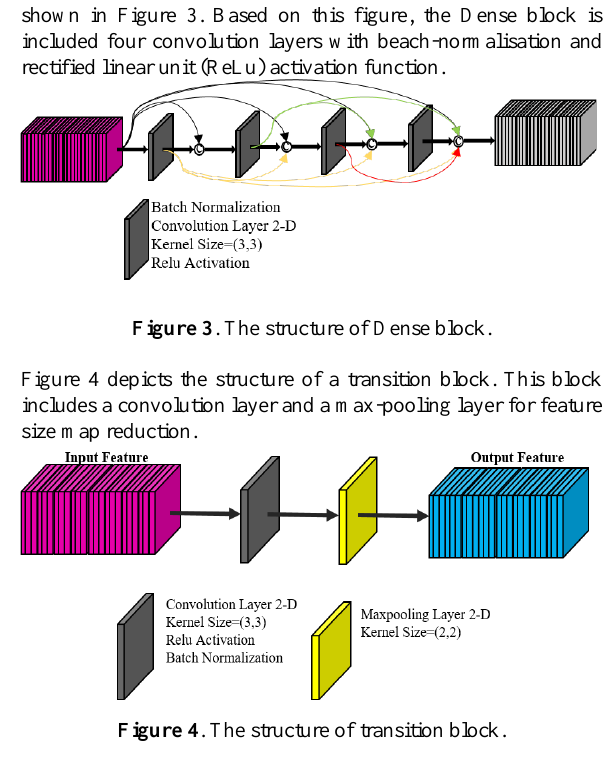
Figure 1 . Flowchart of the proposed method.